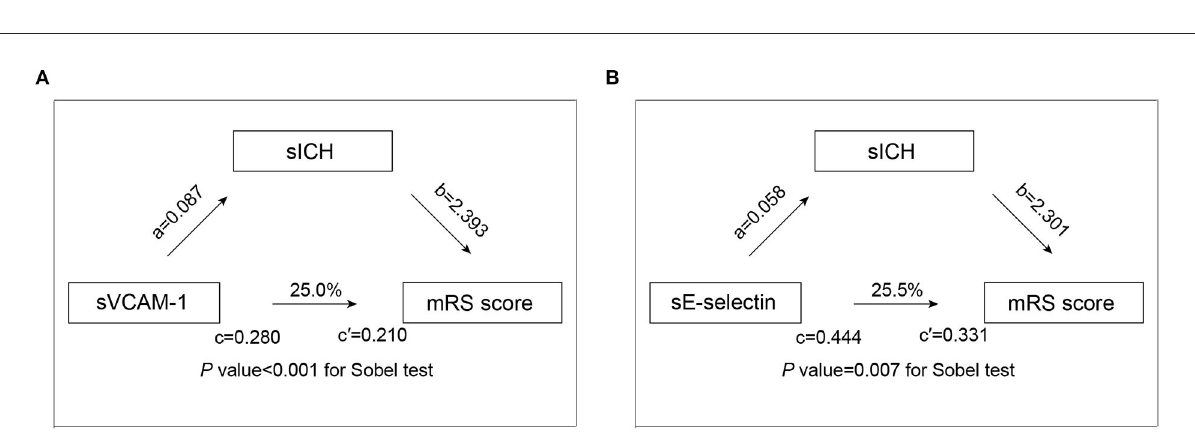
FIGURE2 Mediation analysis by sICH on the association of sVCAM-1 (A) and sE-selectin (B) with functional outcome. a is the regression coefficient of the correlation between adhesion molecules levels and sICH; b is the regression coefficient of the correlation between the sICH and mRS score, using adhesion molecules levels and sICH as independent variables; c is the regression coefficient of the correlation between adhesion molecules levels and mRS score; c ′ is the regression coefficient of the correlation between adhesion molecules levels and mRS score,